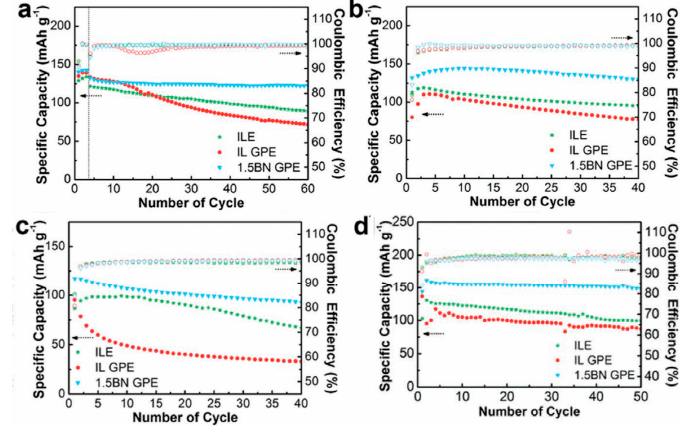
Figure 6. Cycling stability at 0.2 C of ( a ) LFP|Li cell, ( b ) NCM|Li cell, ( c ) LCO|Li cell and ( d ) cycling stability at 0.5 C of LFP|Li cell at 80 °C with liquid, polymer and BN-functionalized-polymer versions of C 3 mpyrTFSI. Adapted with permission from Kim et al. [173].